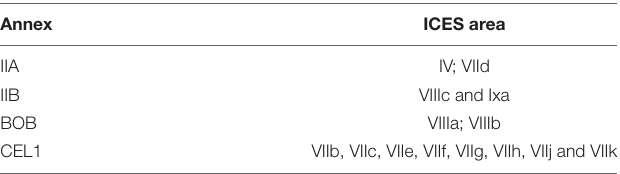
TABLE 1 | International Council for the Exploration of the Sea (ICES) Annexes and the fishing areas they